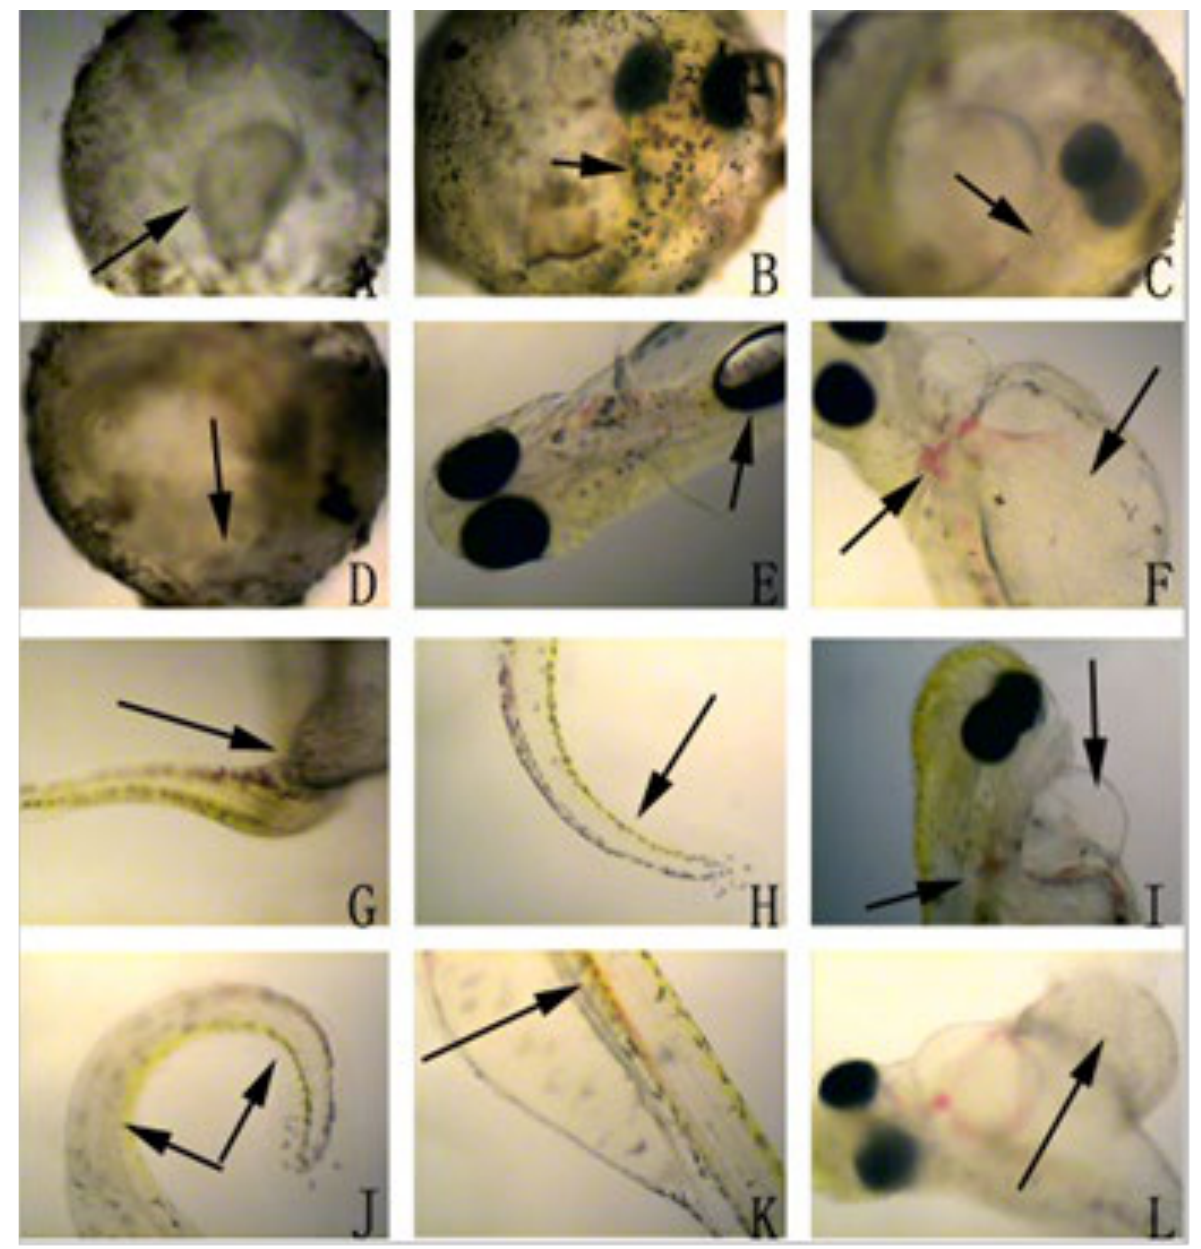
Figure 5. Effects of exposure to La (III) on developing embryos/larvae of rare minnows. The black arrows represent the following: ( A ) embryonic eggs condensation; ( B ) normal embryos; ( C ) melanin depletion; ( D ) embryo autolysis and eyespot disappearance; ( E ) normal larva; ( F ) yolk-sac edema and blood circulation disorder; ( G ) spinal curvature; ( H ) tail ending; ( I ) pericardium edema and blood circulation disorder; ( J ) body bending; ( K ) no functional swim-bladder; ( L ) edema rupture.